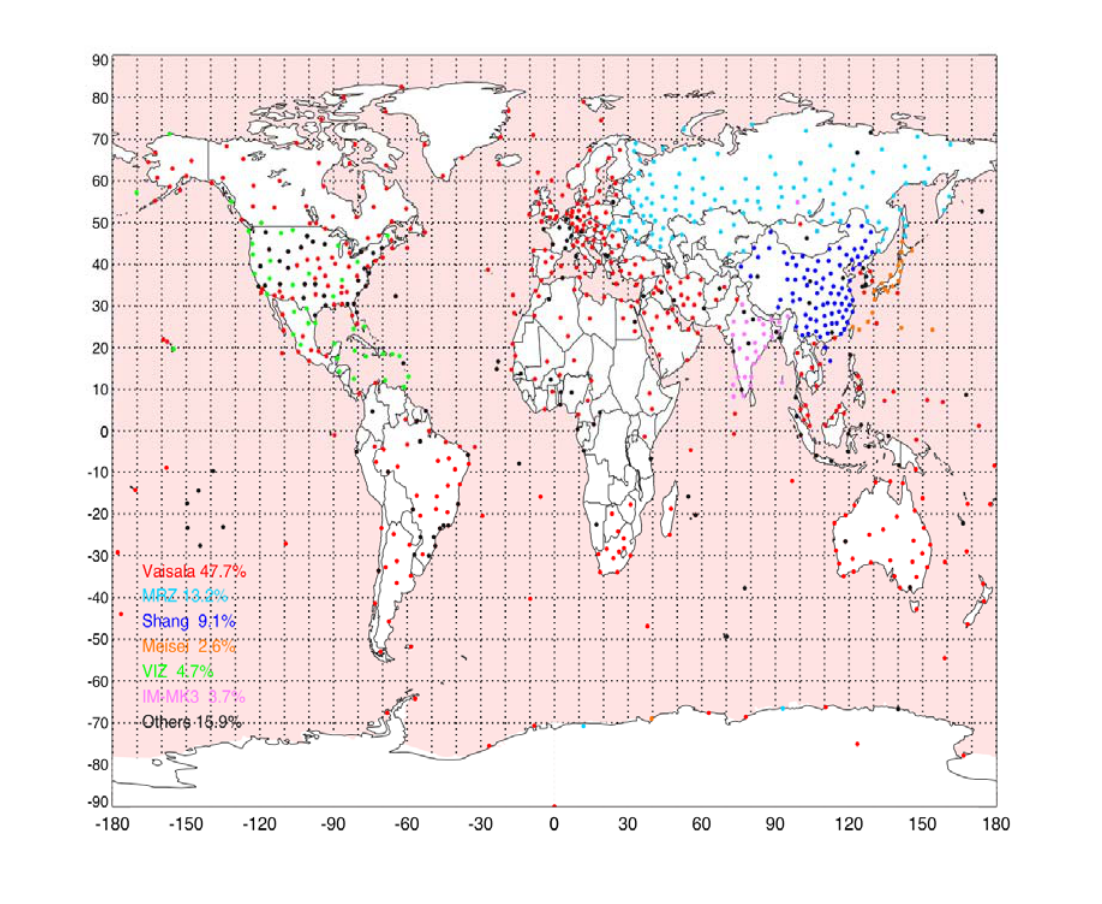
Figure 1. Global distribution of radiosonde stations colored by radiosonde